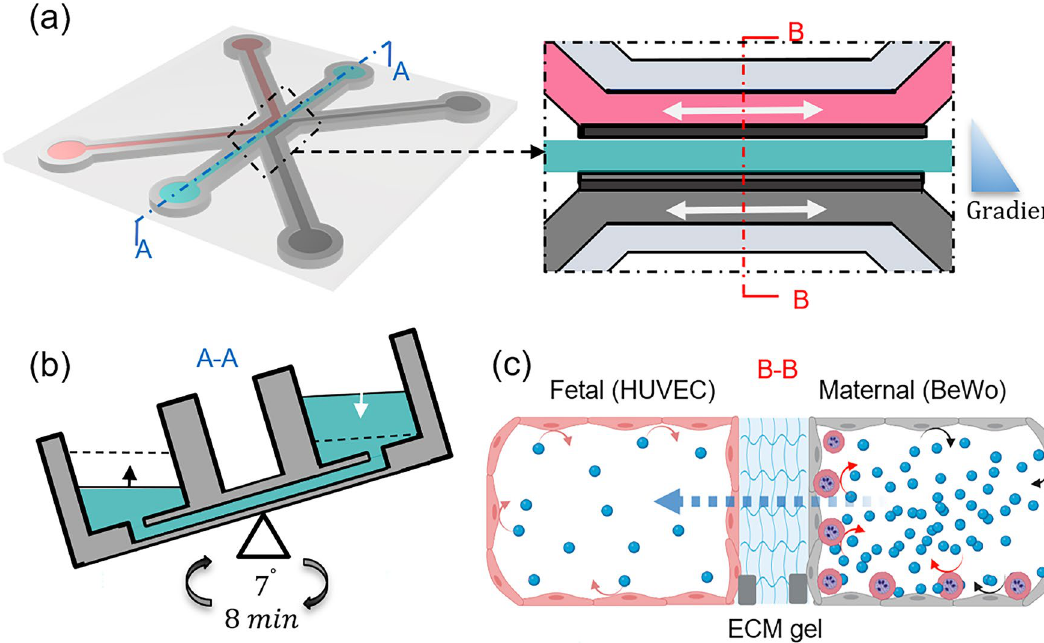
Figure 1. ( a ) Overview of the method for modeling placenta malaria in the 3-lane OrganoPlate platform. ( b ) Flow generation in the microfluidic channels by rocking the OrganoPlate between a + 7° and − 7° inclination every 8 min. ( c ) Schematic of the placental barrier model showing the glucose (blue dots) transport (dashed arrow) and cellular consumption (curved arrows) by BeWo cells, HUVECs and IEs. Created with BioRender.